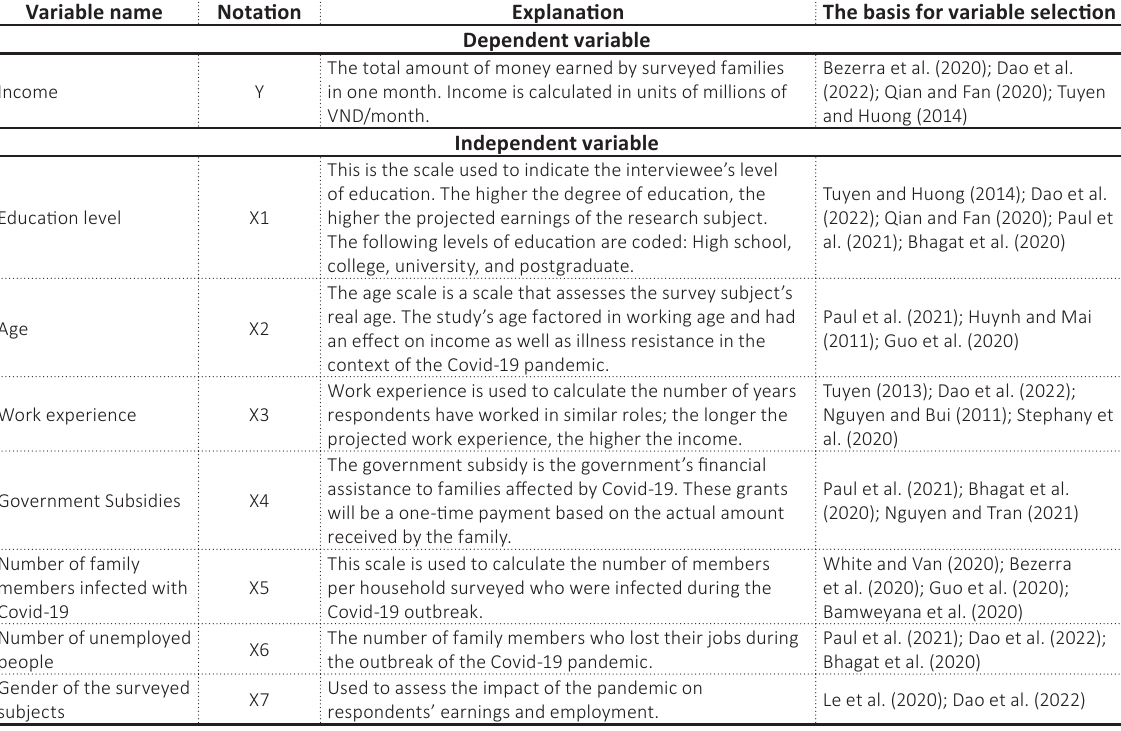
Table 1. Variables of the